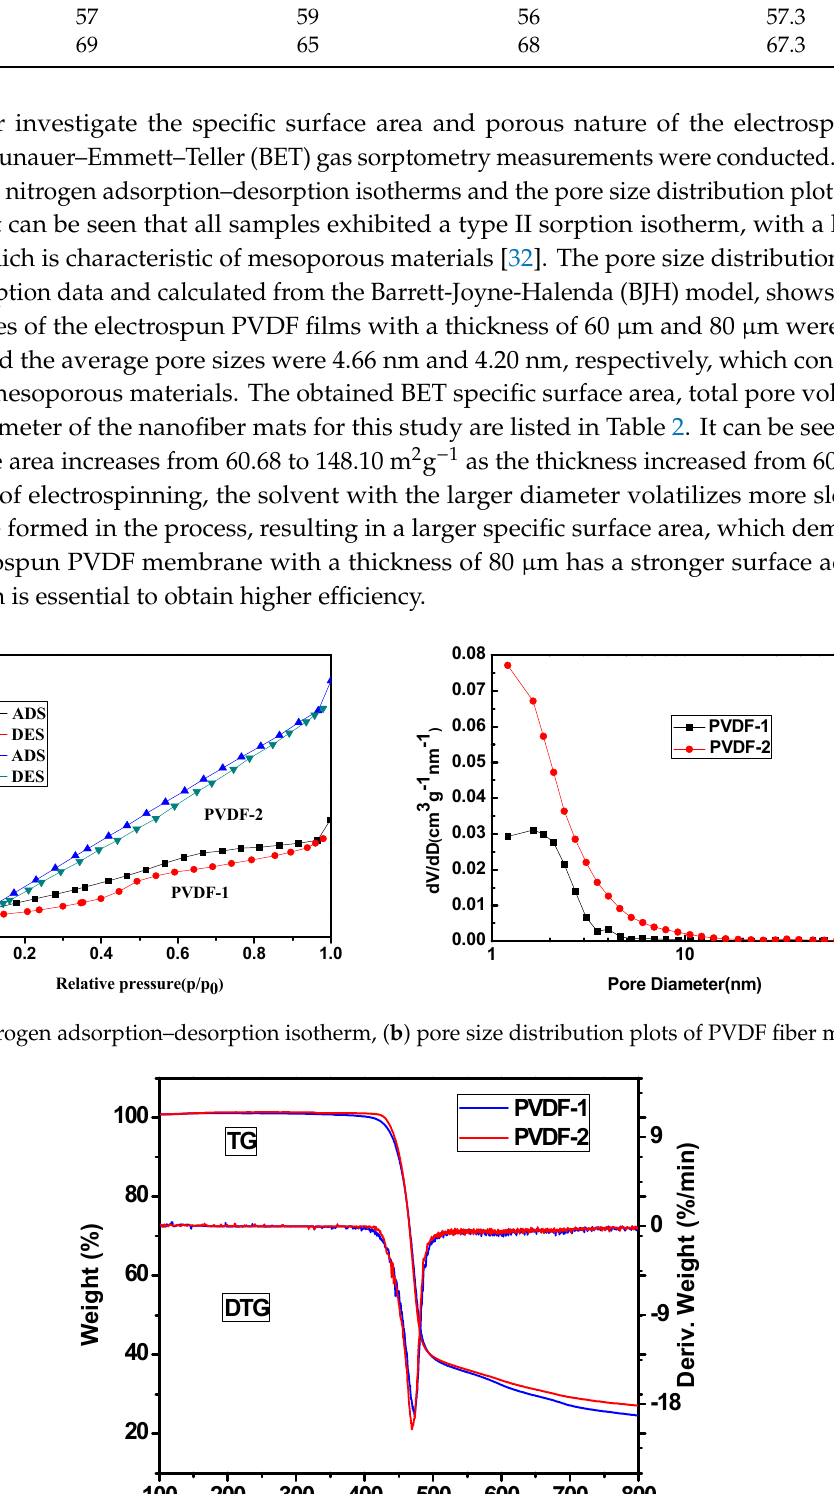
Figure 7. DSC curve of the electrospun PVDF membrane. Figure 8 shows the stress–strain curves of the electrospun PVDF fiber membranes. As can be seen from this figure, the fiber membranes with different thicknesses show distinct ductile fracture characteristics; when the thickness of films increased from 60 to 80 μ m the toughness of the films was notably improved. Compared with PVDF-1, the fracture strength of PVDF-2 was higher, reaching 13.5 MPa. However, the change in thickness did not cause a significant alternation in elongation at the break. This indicates that the strength and toughness of electrospun PVDF membranes are improved when the thickness is increased. The excellent strength and toughness of the electrospun PVDF film indicates that the film has robust mechanical properties, which is